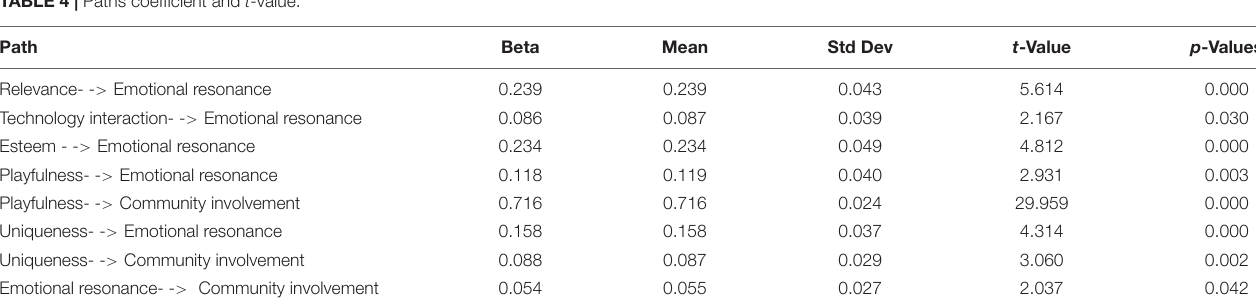
TABLE 4 | Paths coefficient and t